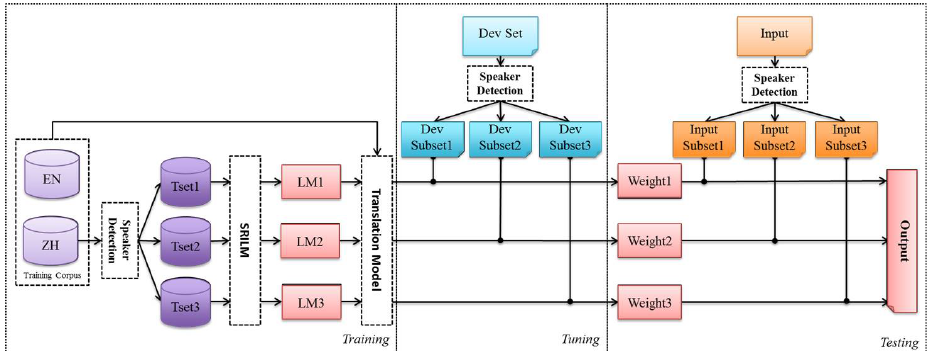
Figure 8. Personalized dialogue translation model using speaker